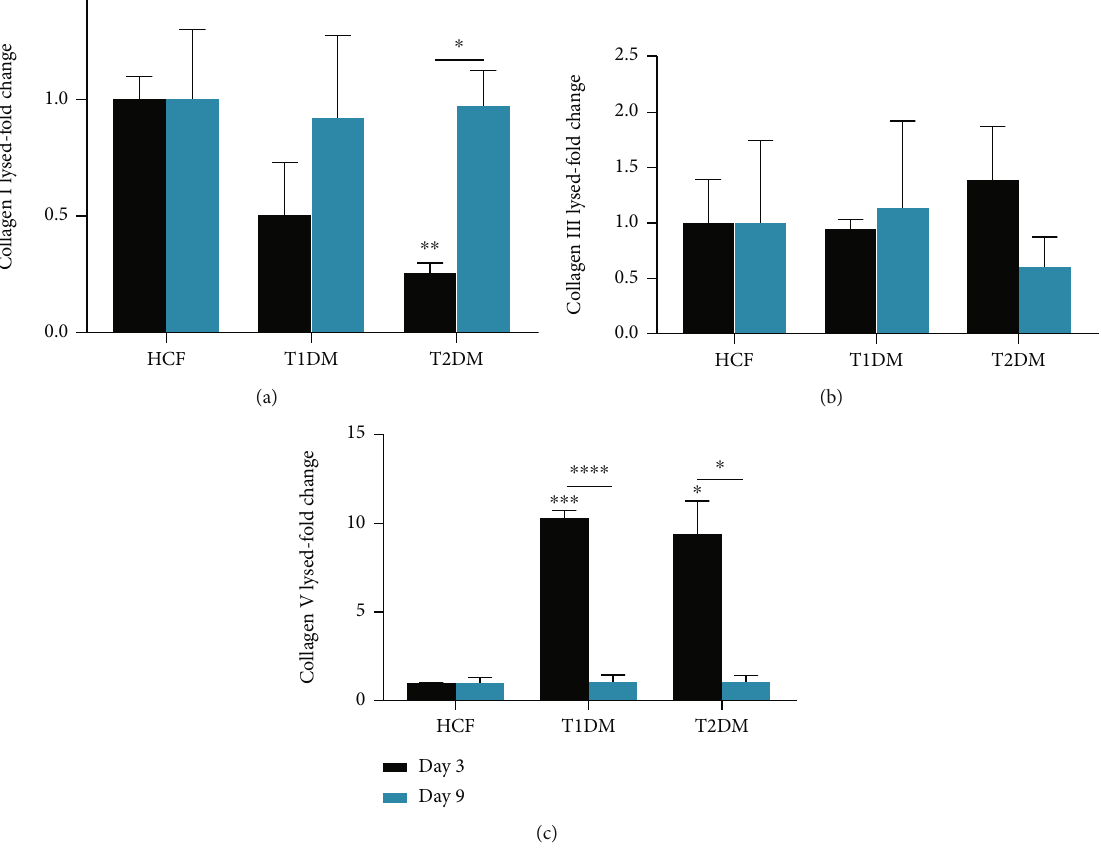
Figure 4: (a) Collagen I (Col I), (b) collagen III (Col III), and (c) collagen V (Col V) protein levels in conditioned media of HCF, T1DM, and T2DM on days 3 and 9. Col I expression signi fi cantly decreased on day 3 but not at day 9 compared to the HCFs. T1DM and T2DM show signi fi cant increases in Col V expression, followed by signi fi cant decreases of secretion at day 9. Welch ’ s unpaired t -test and/or ordinary one-way ANOVA ( n = 4 ) was used to analyze the results. Error bars represent standard deviation ( ∗∗∗∗ denotes p < 0 : 0001 , ∗∗∗ denotes p < 0 : 001 , ∗∗ denotes p < 0 : 01 , and ∗ denotes p < 0 : 05